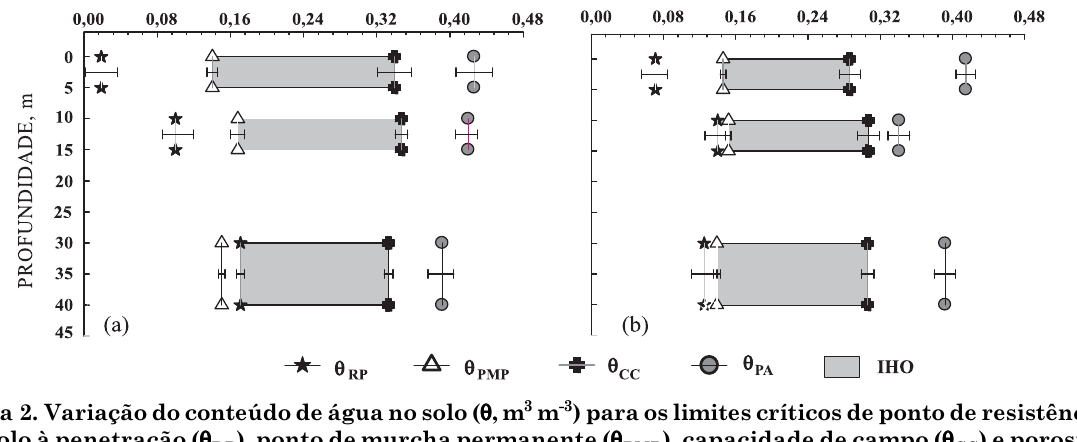
), capacidade de campo ( θθθθθ ) e porosidade PMP CC